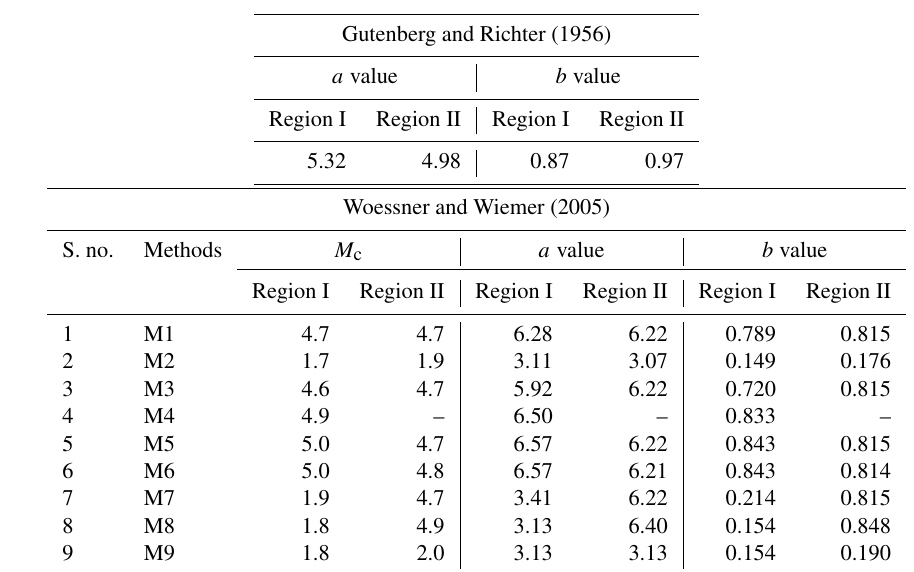
Table 1. Variation in magnitude of completeness ( M c ) and a and b parameters of G–R relationship.